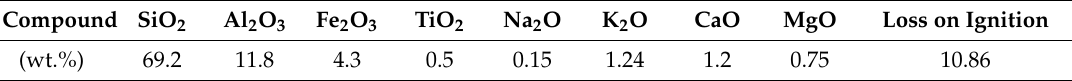
Table 8. Chemical composition of diatomaceous earth from the Jawornik deposit. Compound SiO